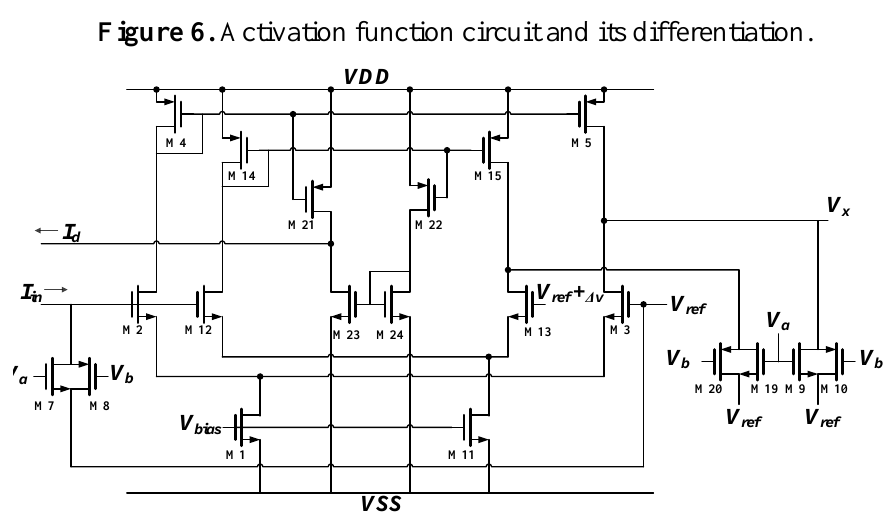
Figure 6. Activation function circuit and its differentiation.